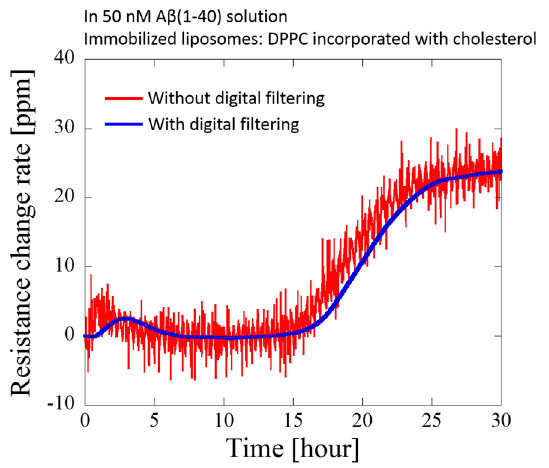
Figure 2. Resistance change rate of microcantilever sensor immobilized with DPPC liposomes incorporated with cholesterol in 50 nM A β (1-40) solution with and without digital filtering